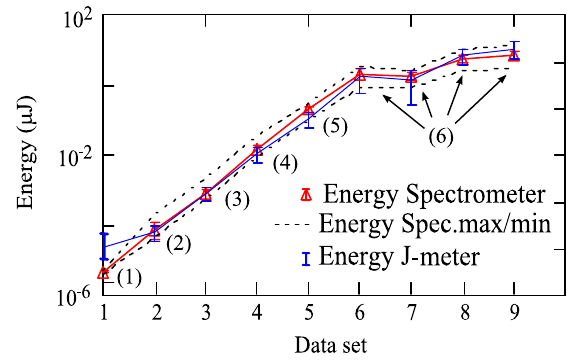
FIG. 9. Comparison of energy measured with pyroelectric detector (blue) and integrating the spectral images with the appropriate calibration factor (red). Error bars (red) correspond to 1 standard deviation over 100 shots. Numbers in parentheses indicate, for each data set, the undulator sections set at